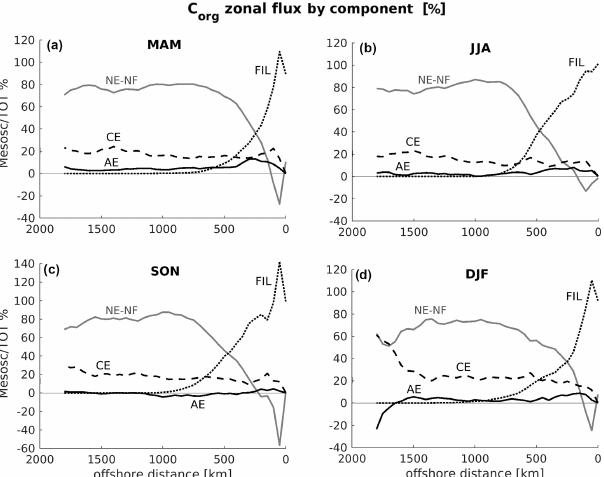
Figure 4. Seasonality of eddy, filament, and non-eddy–non-filament contribution to the total offshore transport of C org over CanUS inte- grated throughout the first 100m depth. The plots show the percent- age of the total offshore C org flux represented by the filament flux (FIL), the cyclonic eddy flux (CE), the anticyclonic eddy flux (AE) and the non-eddy–non-filament flux (NE–NF). Percentages can go above 100% when one flux component is negative, i.e., directed onshore. Subpanels: (a) spring (MAM), (b) summer (JJA), (c) fall (SON), and (d) winter (DJF). Please, note that the y axis scale of SON differs from the other